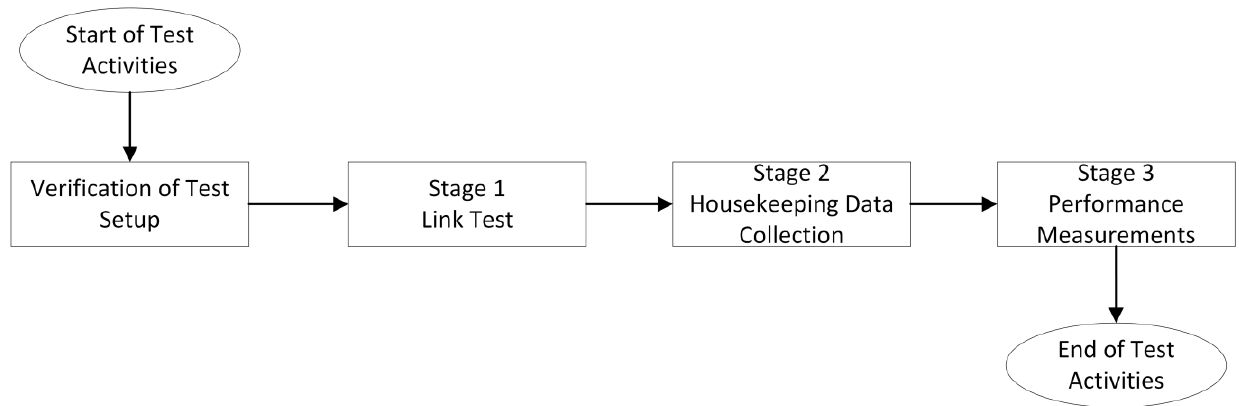
Figure 5. Test scenario execution steps.